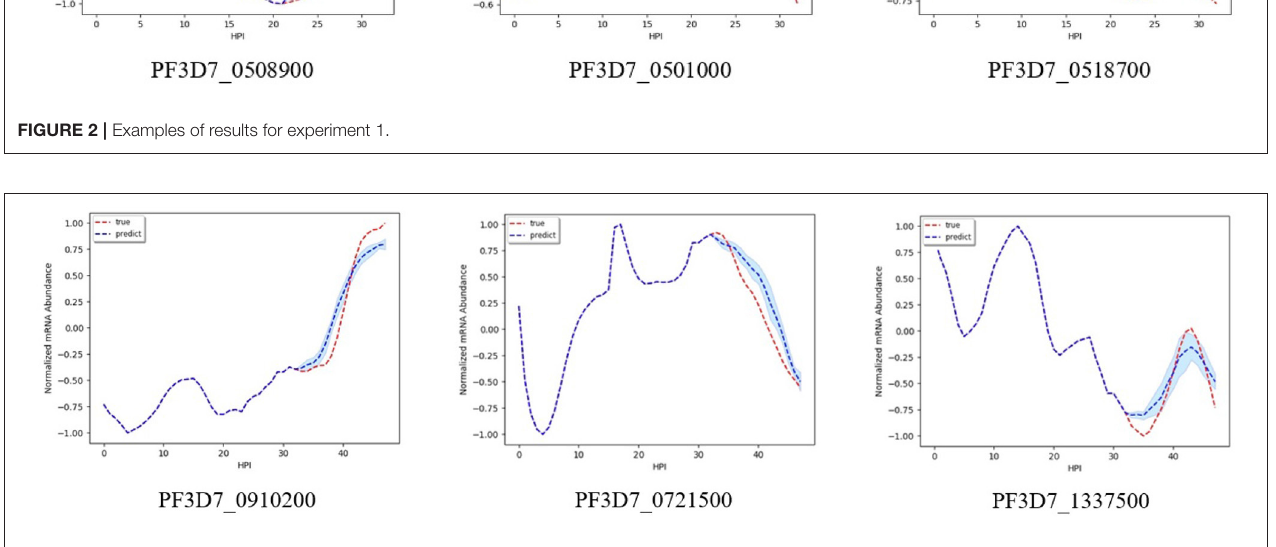
FIGURE 3 | Examples of results for experiment 2.